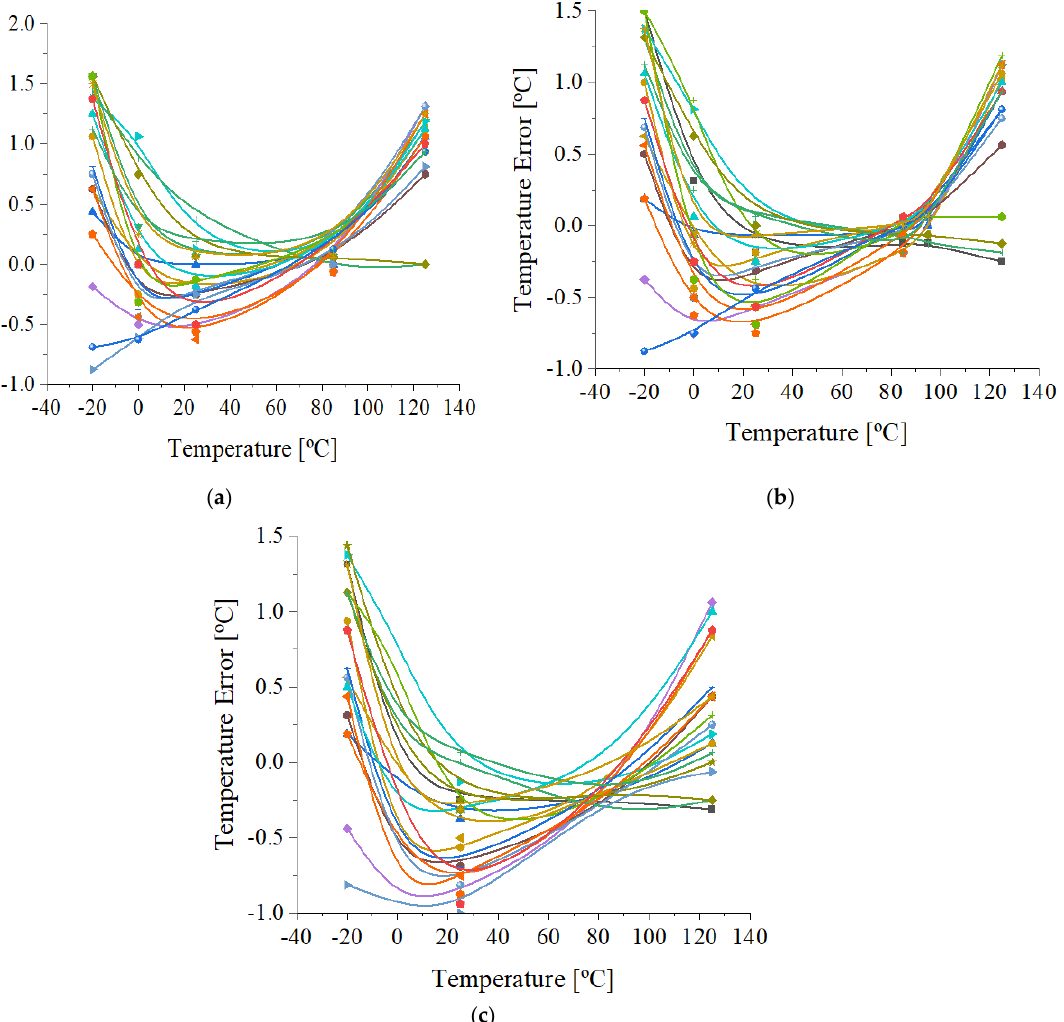
Figure 9. ( a ) Measured temperature error of 20 trimmed DTS samples at 1.7 V; ( b ) measured temperature error of 20 trimmed DTS samples at 1.8 V; ( c ) measured temperature error of 20 trimmed DTS samples at 1.9